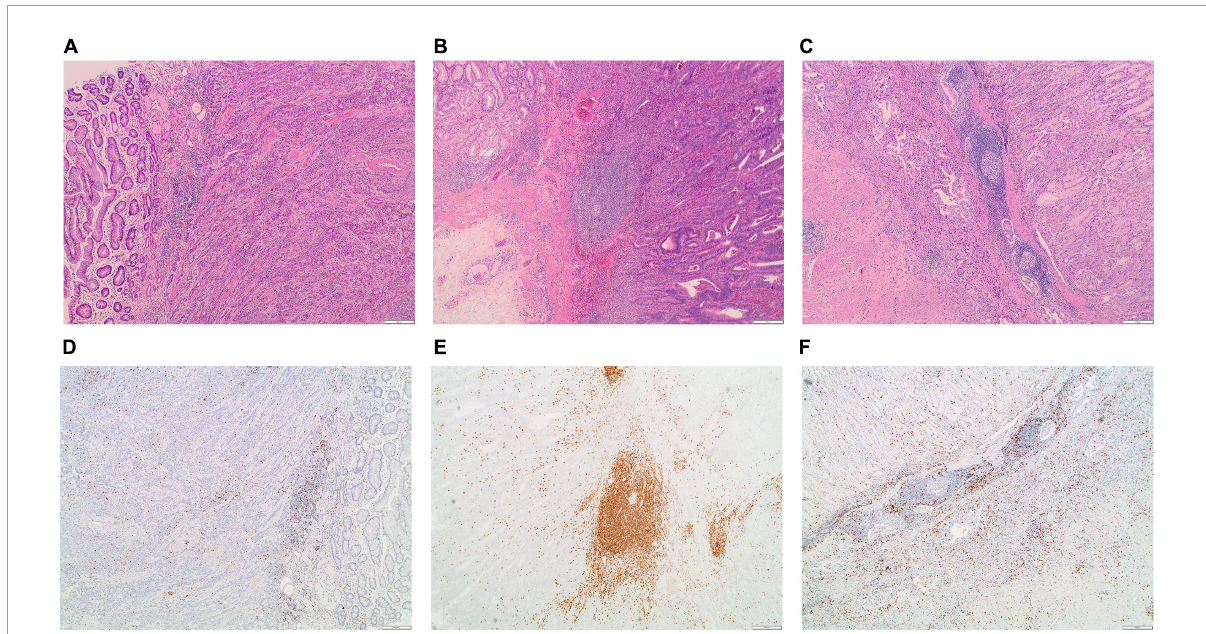
FIGURE3 Examples of the morphology and CD8 staining for lymphocyte infiltration in EBVaGC patients. (A) Representative images for low-lymphocyte infiltrated tumor; (B,C) representative images for high-lymphocyte infiltrated tumors. The corresponding images for the staining of CD8 in the low-lymphocyte infiltrated tumor (D) and in high-lymphocyte infiltrated tumors (E,F)